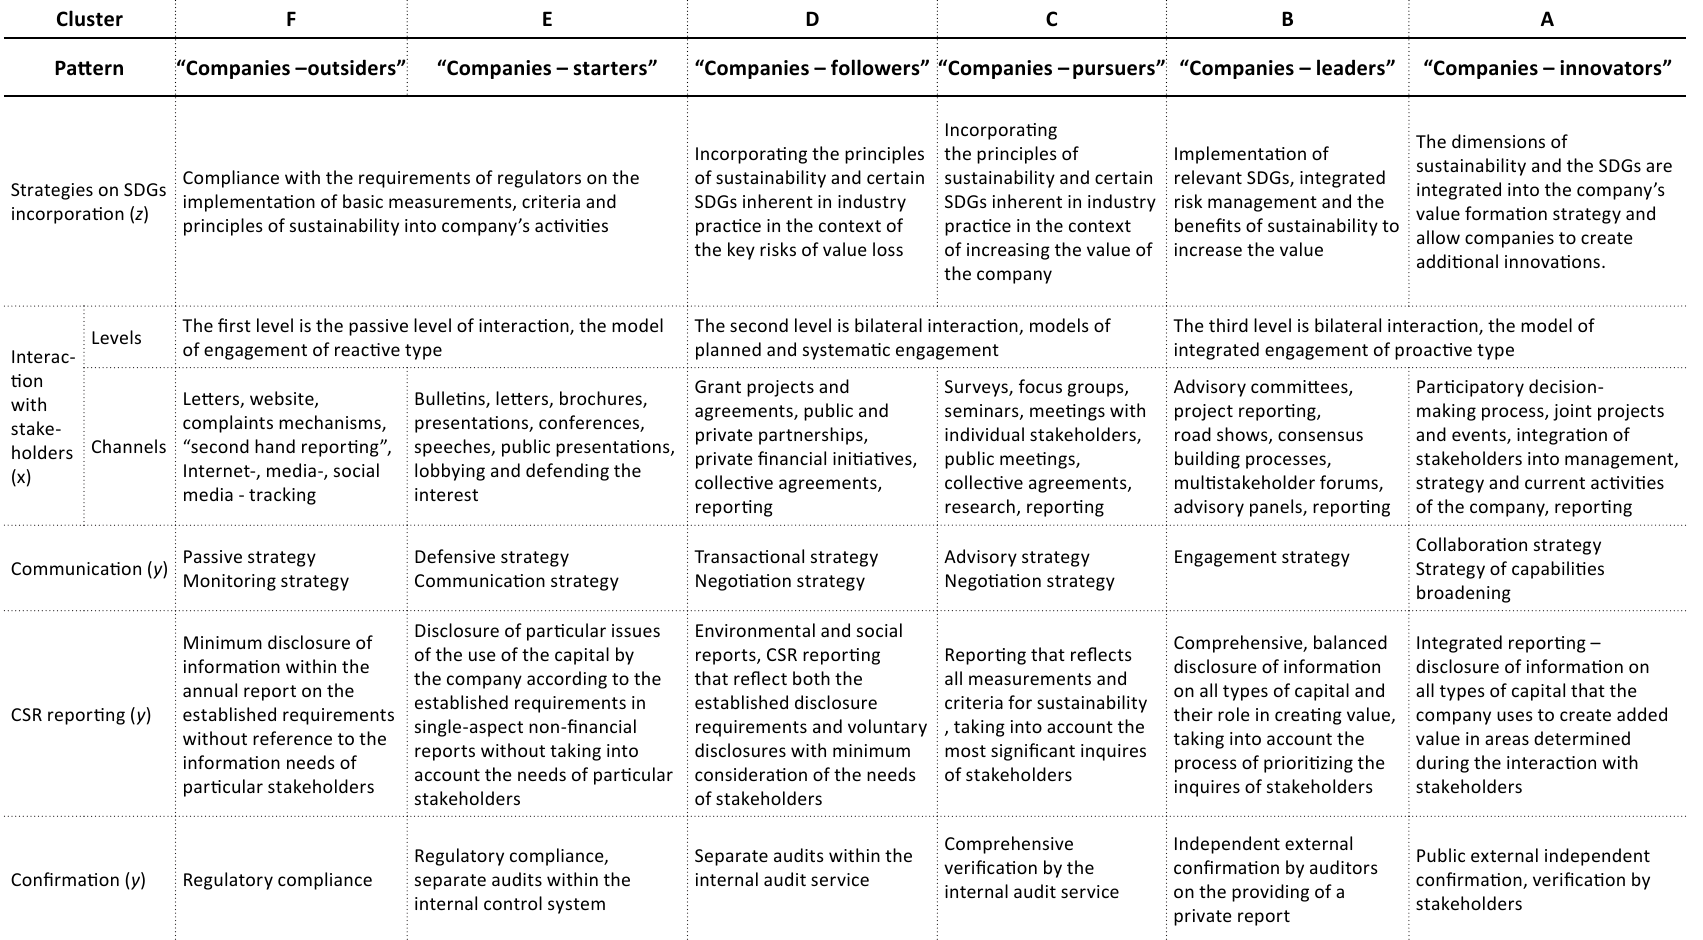
Table B1. Qualitative characteristics of companies’ responsible behavior patterns by strategic benchmarks in achieving the SDGs, communication with stakeholders and approaches to information disclosure in the CSR